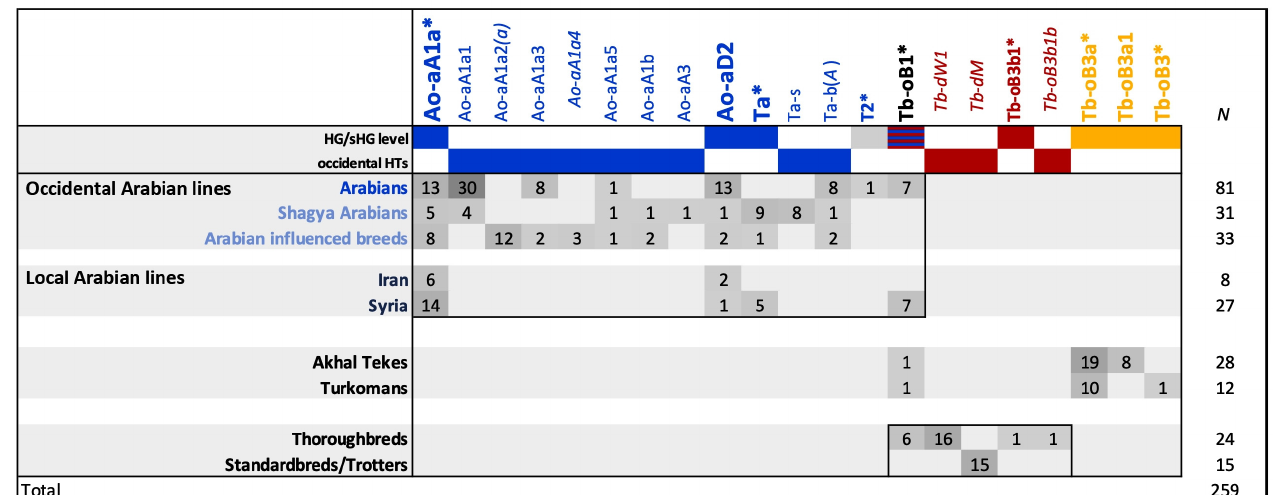
Figure 4. MSY Haplotypes in globally active Arabian lines, Middle Eastern Arabians, and other breeds. Haplogroup (bold) and haplotype distribution in breed or breed groups in absolute num- bers (N = total number). Thoroughbred HG/HTs are marked in red, Arabian in blue, and Akhal Teke/Turkoman in yellow. The Tb-oB1* subhaplogroup was detected in Thoroughbreds, Akhal Teke/Turkoman, and in a small subset of Arabians, but the ancestry of horses carrying this hap- logroup remains